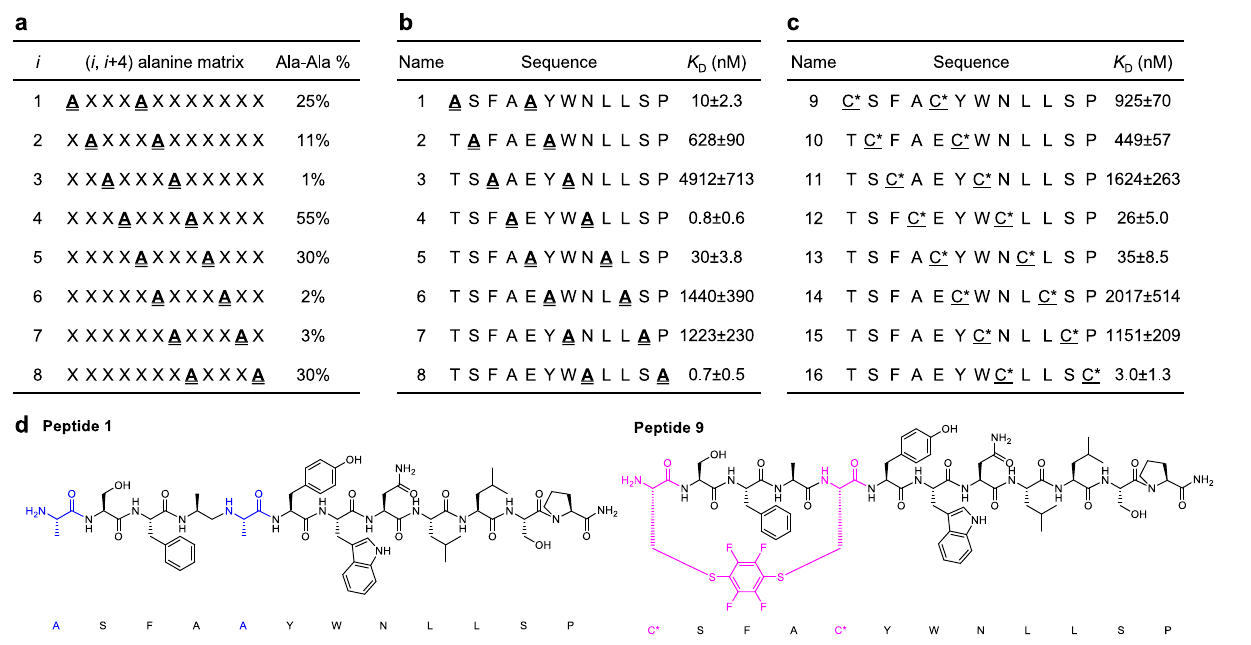
Fig. 3 High-frequency alanine pairs observed in the af fi nity selection show high tolerance for double mutations. a ( i, i + 4) pairwise alanine substitution frequency extracted from Fig. 2c. b Binding af fi nity of ( i, i + 4) pairwise alanine-substituted peptides. c Binding af fi nity of ( i, i + 4) per fl uoroaryl stapled peptides. The three most potent stapled peptides correlate with the three highest frequency pairwise alanine substitutions. Therefore, the ( i, i + 4) pairwise alanine substitution frequencies accurately indicate retention of high af fi nity in peptide binders substituted at the corresponding positions. Binding dissociation constants ( K D ) were determined by a competition assay using BLI. d Representative chemical structures of an ( i, i + 4) pairwise alanine- substituted peptide ( 1 ) and an ( i, i + 4) per fl uoroaryl-stapled peptide ( 9